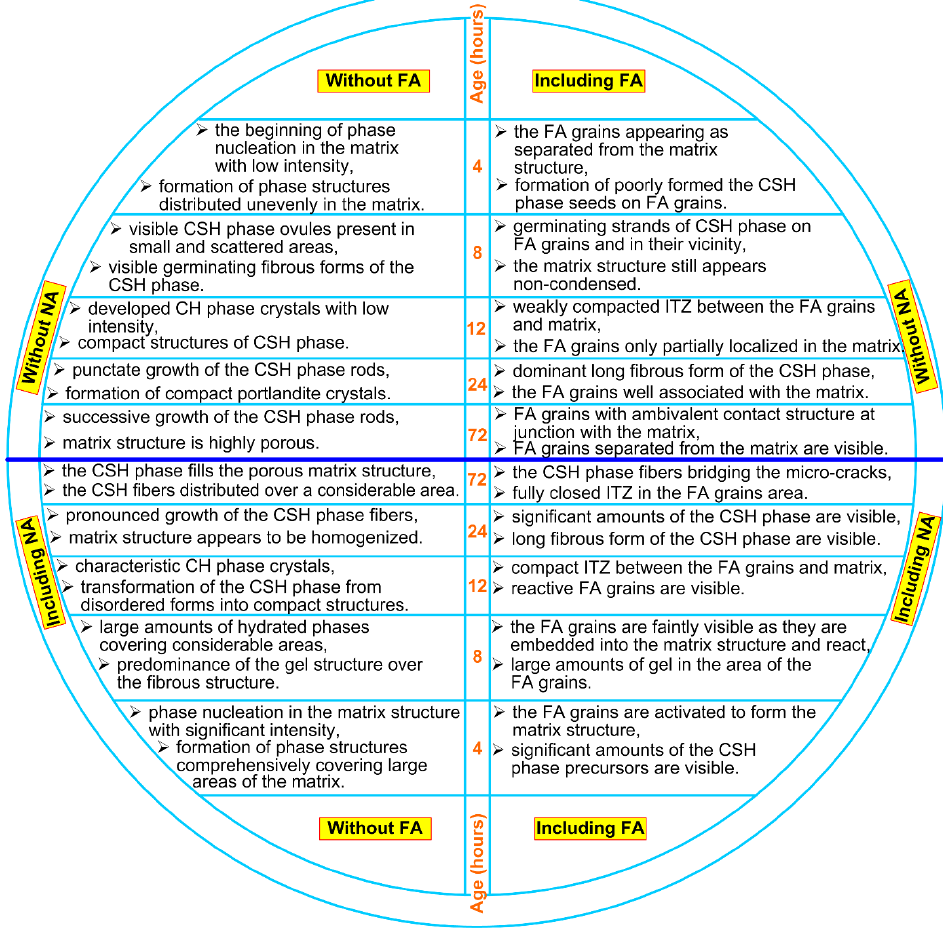
Figure 8. The material characteristics, features and morphology of the cement matrix, visible on SEM images of analyzed composites, at particular periods of curing.